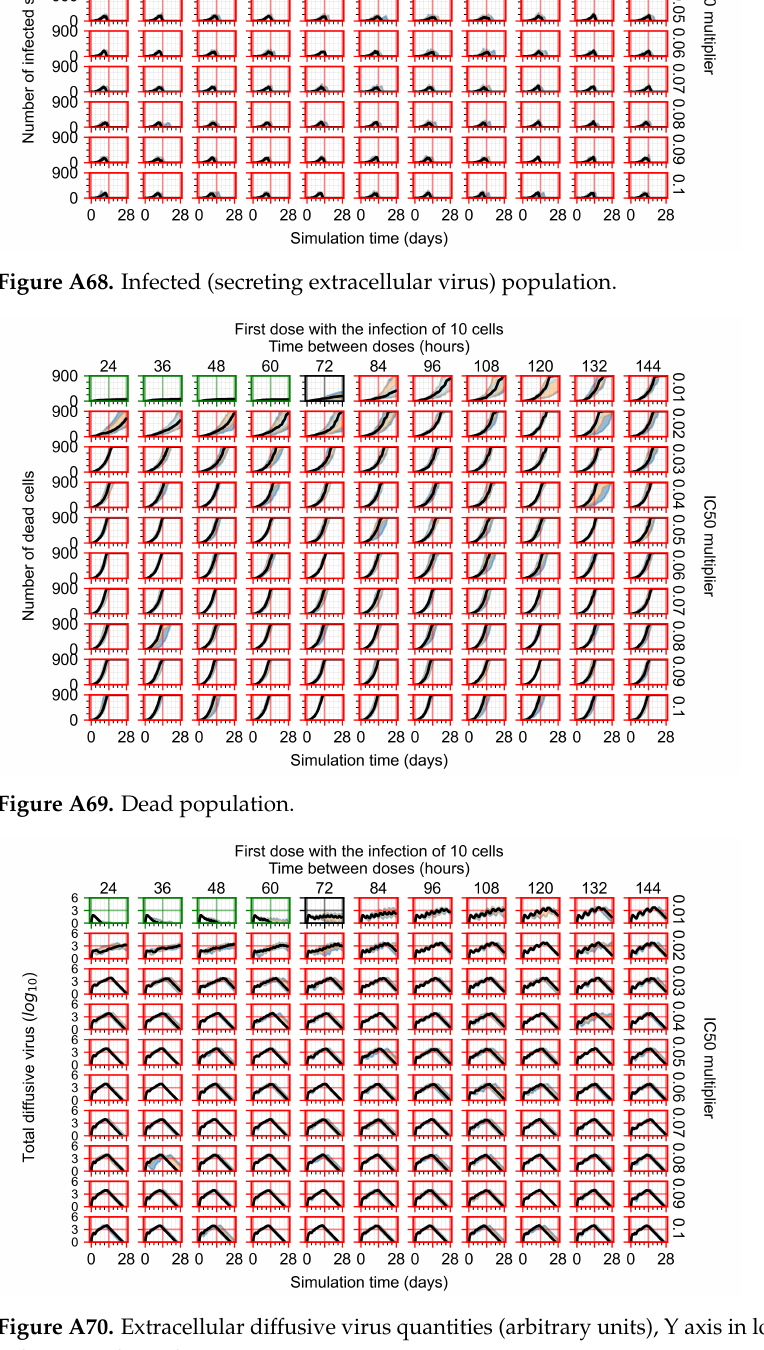
Figure A70. Extracellular diffusive virus quantities (arbitrary units), Y axis in log scale, and exponent values as tick